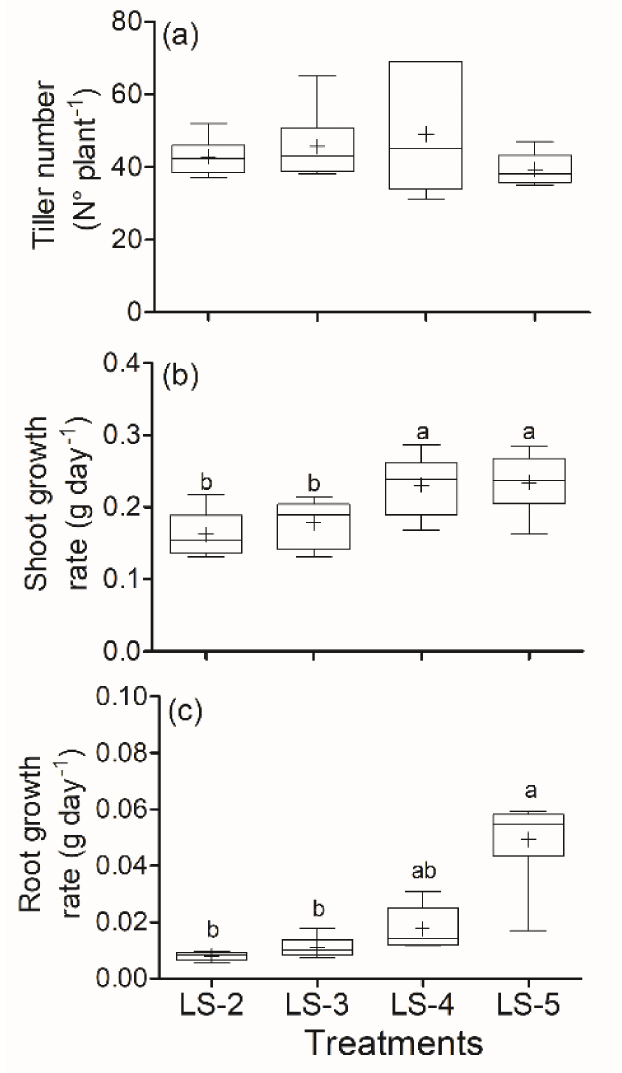
Figure 4. Tiller number ( a ), shoot growth rate ( b ) and root growth rate ( c ) for B. valdivianus defoliated by leaf stage (LS). The defoliation frequencies were based on defoliation at leaf stage 2 (LS-2); leaf stage 3 (LS-3); leaf stage 4 (LS-4); leaf stage 5 (LS-5). Lowercase letters indicate differences between treatments. + indicates the mean, while bars and boxes are the distribution of the population (quartiles) ( n =